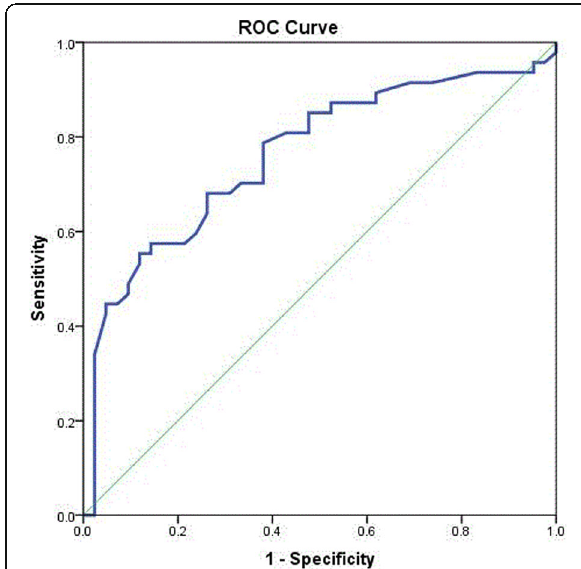
Fig. 4 ROC curve analysis of CRP between stable and